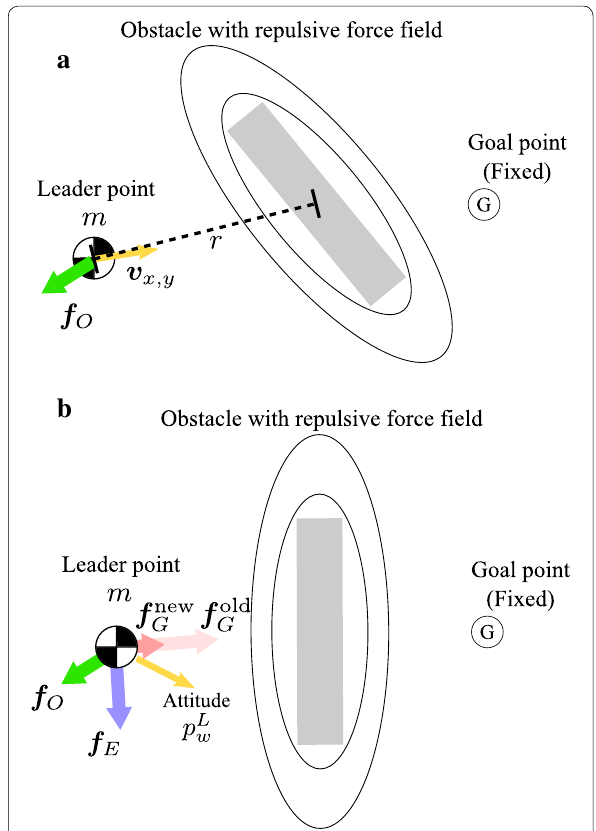
Fig. 17 Illustrations of the forces to avoid obstacles and reach the goal a to avoid collision with obstacles, repulsive forces according to the Mahalanobis distances with them are added; b to escape from stationary points caused by obstacles, a part of the attractive force is rotated along with a tangential direction of the contour lines. a Repulsive force, b explorative